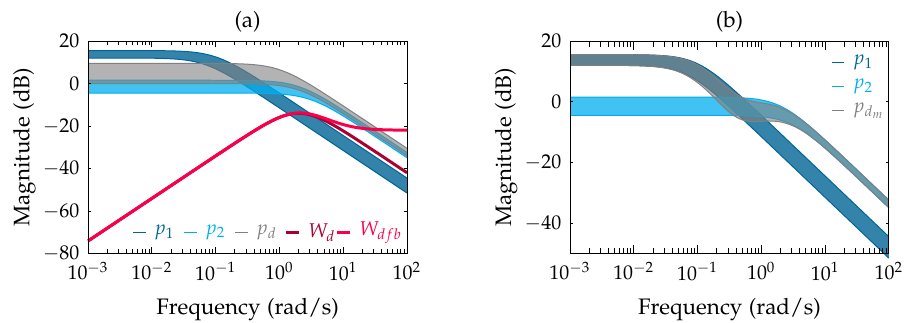
Figure 2. Magnitude frequency responses of plants: ( a ) performance specifications; ( b ) outcome plant after individual feedforward prefiltering.